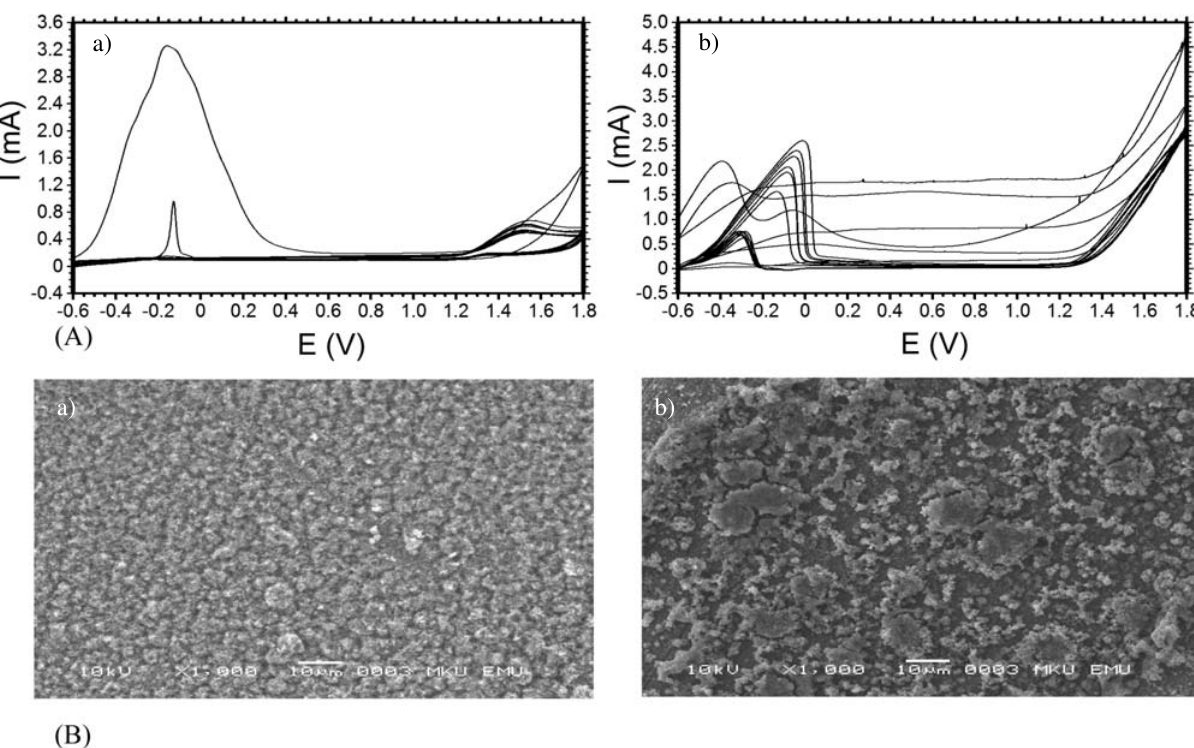
Fig. 4. Film growth curves (A) and SEM images (magnification: 1000) (B) of layers obtained on CS/ZnFe electrode in a) 0.20 M NaOX b) 0.20 M NaTart solution, scan rate: 50 mV s –1 .